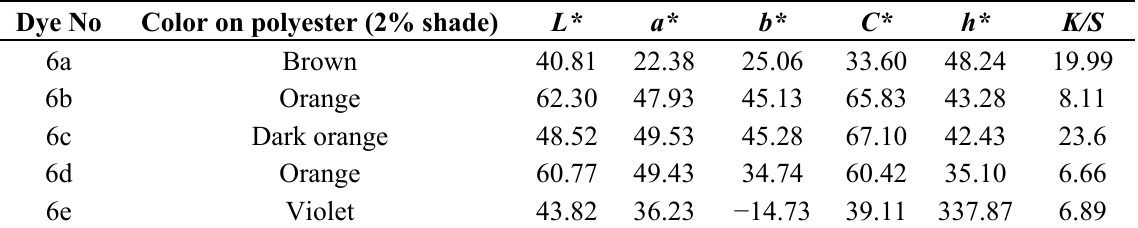
Table 1. Shade and optical measurements of the azo disperse dyes on the polyester fabrics using conventional dyeing